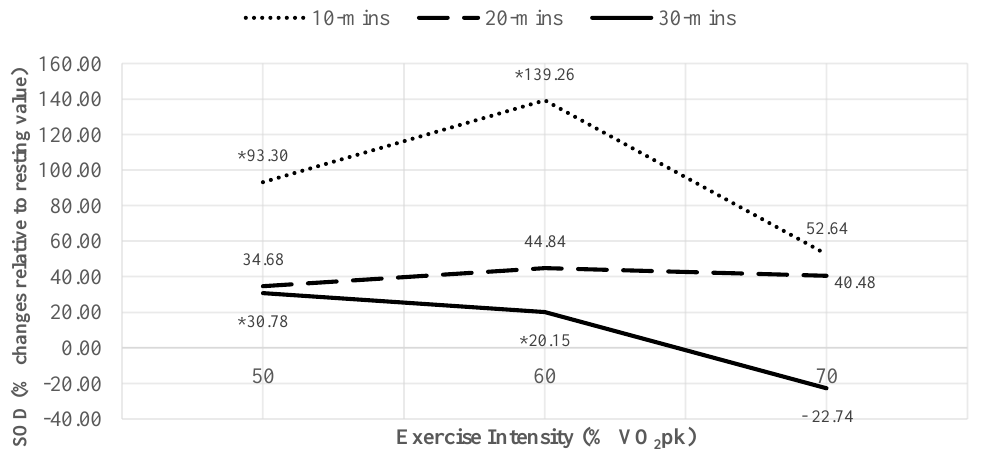
. VO 2 pk during exercise. * significantly